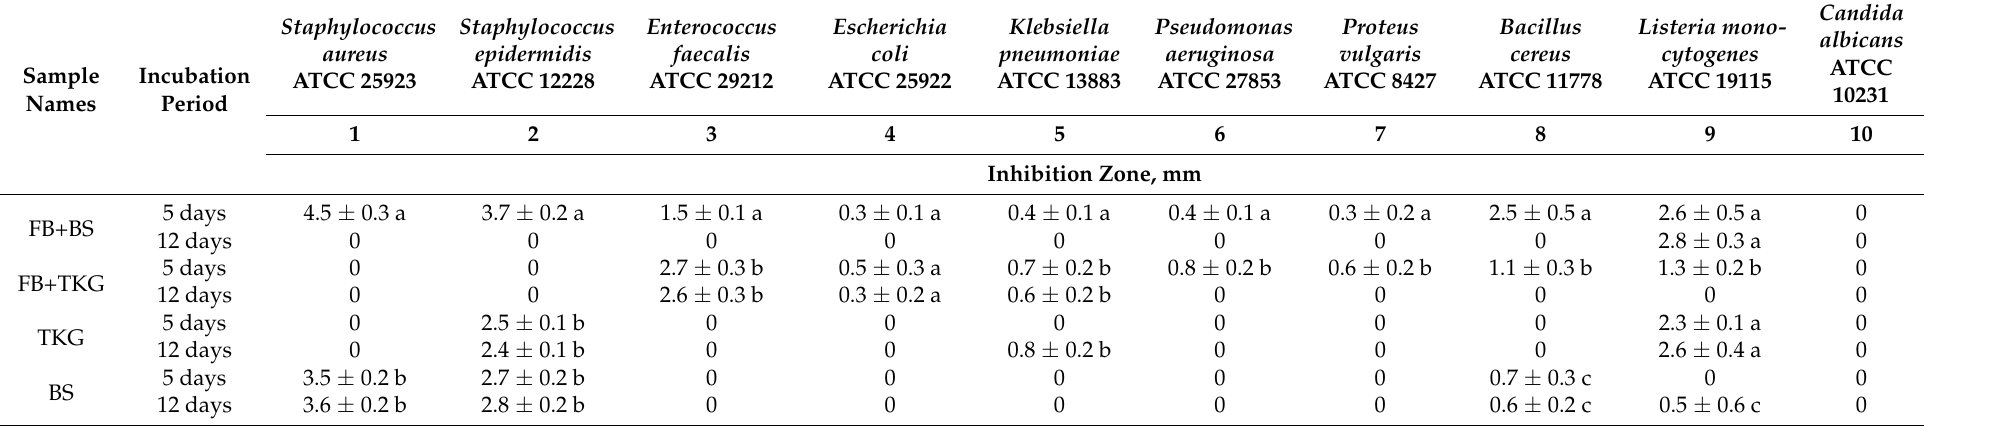
Table 1. Potential of antimicrobial activities of common buckwheat fermented with Tibetan kefir grains and birch